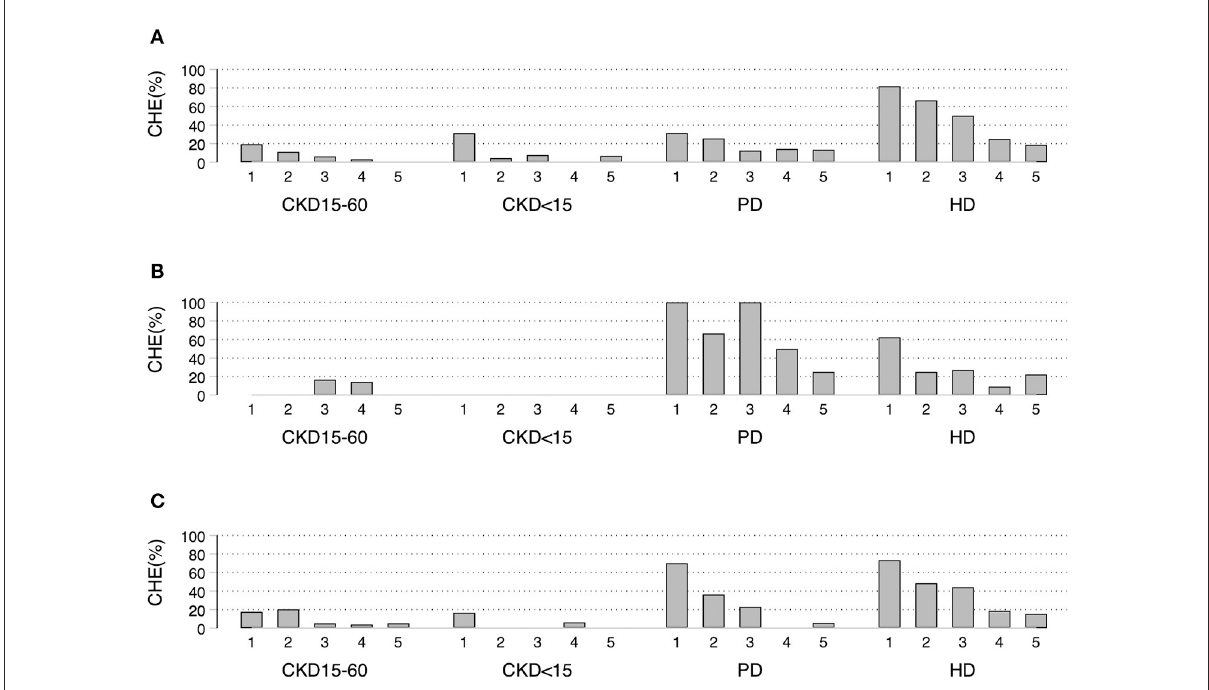
FIGURE2 Socioeconomic status quintiles-specific proportion of Catastrophic Health Expenditure (CHE40) under different schemes. (A) UCS, (B) SSS, (C) CSMBS CHE40 defined as households in which out-of-pocket payments for health care was at least 40% of household capacity to pay. UCS, Universal Coverage Scheme; SSS, Social Security System; CSMBS, Civil Servant Monetary Benefit Scheme. CKD15-60 chronic kidney disease with eGFR 15-60 ml/min/1.73 m 2 , CKD < 15 chronic kidney disease with eGFR < 15 ml/min/1.73 m 2 , PD, peritoneal dialysis; HD,